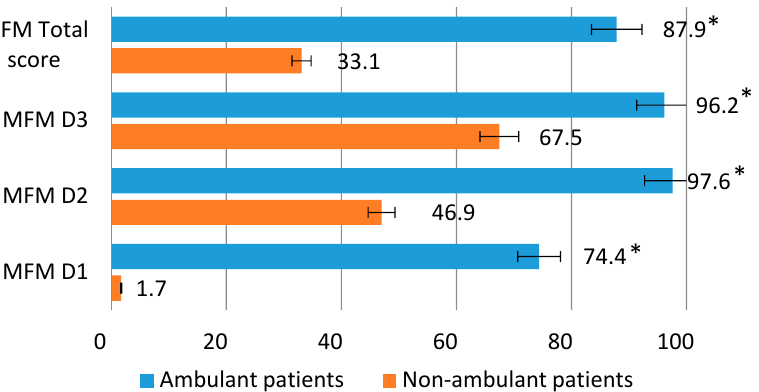
Figure 1. Average values of the Motor Function Measure scale (%) for patients able and unable to walk independently. * p ≤ 0.01.